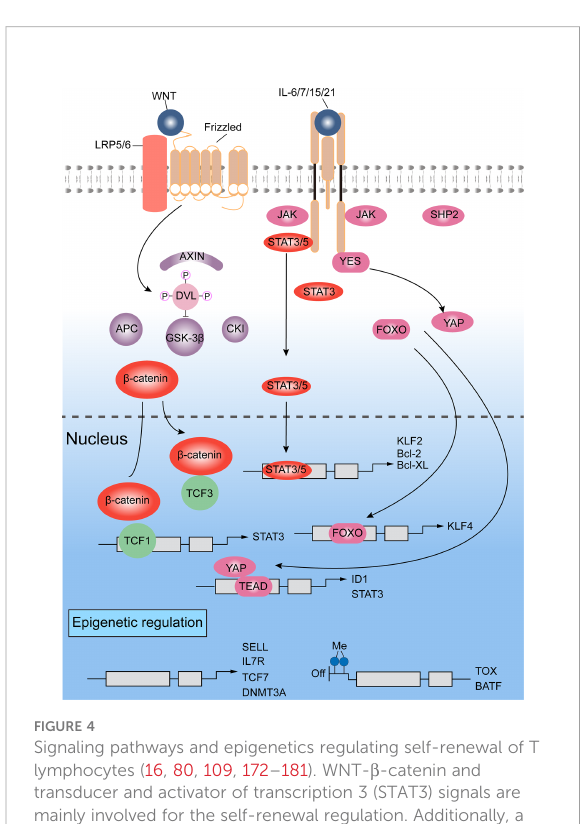
FIGURE 4 Signaling pathways and epigenetics regulating self-renewal of T lymphocytes (16, 80, 109, 172 – 181). WNT- b -catenin and transducer and activator of transcription 3 (STAT3) signals are mainly involved for the self-renewal regulation. Additionally, a crucial role is played by chromatin modi fi ers, which can add repressive histone marks to genes responsible for maintaining stemness, or catalyze DNA methylation on genes regulating